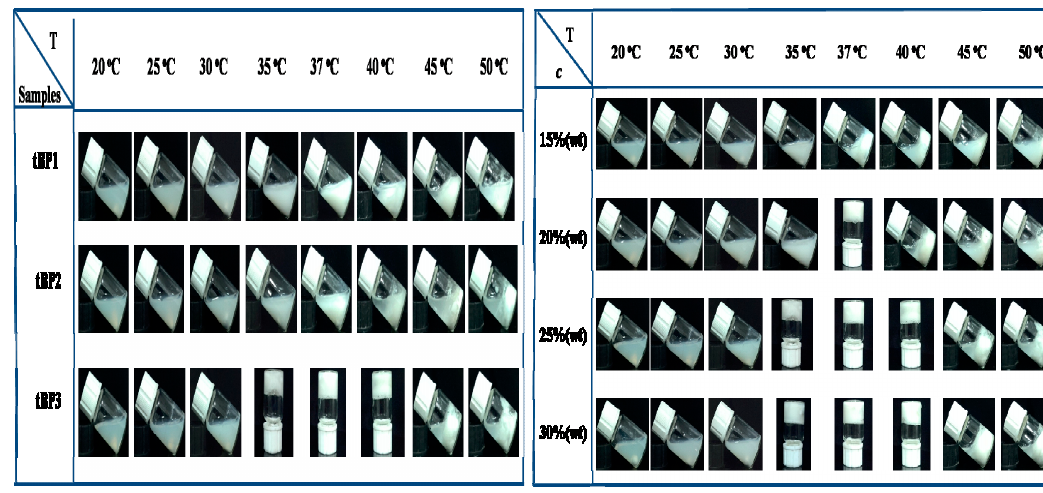
Figure 6. Photographs of P(MEO 2 MA- co -OEGMA)- b -PCL- b -P(MEO 2 MA- co -OEGMA) aqueous solutions at different temperature: ( left ) tBP1, tBP2, and tBP3 aqueous solutions (25 wt %) at different temperatures; and ( right ) various concentrations of tBP3 aqueous solutions at different temperatures.